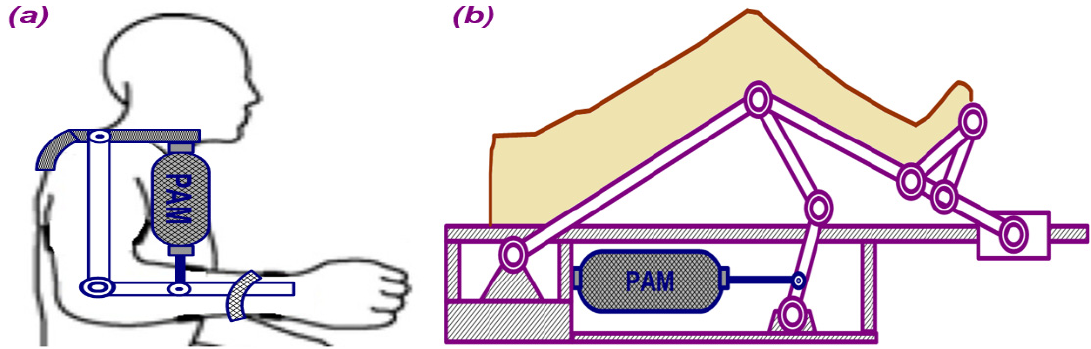
Figure 1. Diagrams for the single PAM-actuated elbow orthosis ( a ) and CPM device ( b ).